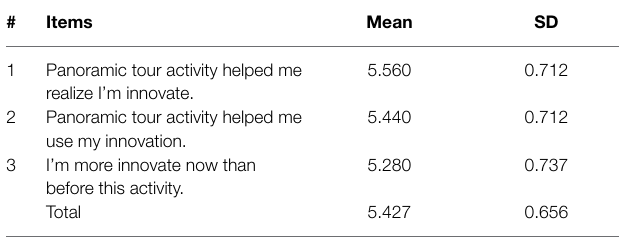
TABLE 5 | Perceived changes in